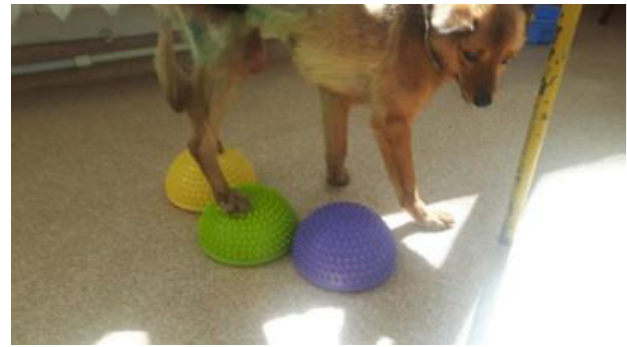
Figure 4. Regaining proprioception and balance.